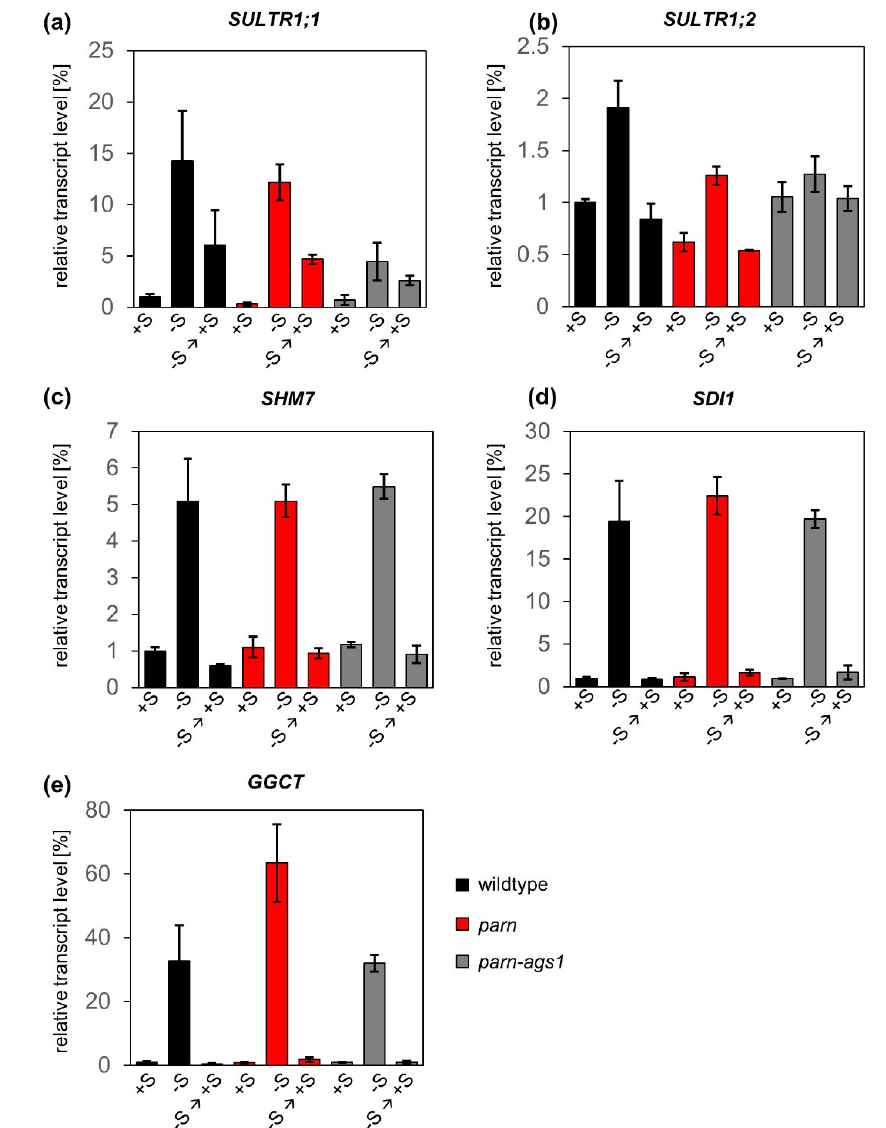
Figure 2. At PARN is not required for the degradation of sulfur starvation-induced transcripts upon the resupply of the macronutrient. Relative transcript levels of SULTR1;1 ( a ), SULTR1;2 ( b ), SHM7 ( c ), SDI1 ( d ) and GGCT ( e ) upon regular sulfur supply ( + S, 500 µ M), starvation (-S, two weeks at 0 µ M) and recovery (-S → + S, 3 h at 500 µ M) in roots of parn (red), parn-ags1 (grey) and wildtype plants (black). Results were normalized to the expression values measured for wildtype plants under full nutrient supply. Bars represent standard errors (n =